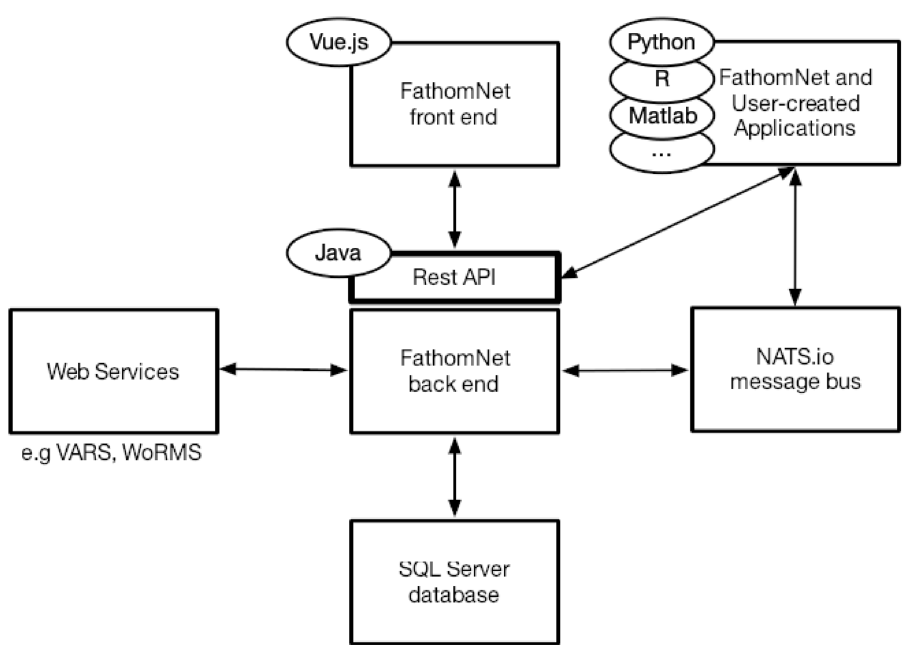
Figure 3. FathomNet database software architecture. The FathomNet software architecture includes a Java Rest API, SQL Server database, a NATS.io messaging bus, and external web services (e.g., WoRMS, VARS,